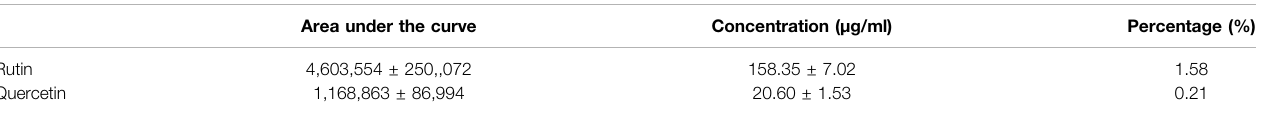
TABLE 2 | Concentration of quercetin and rutin in 10 mg Parkia speciosa crude extract. Area under the curve Concentration